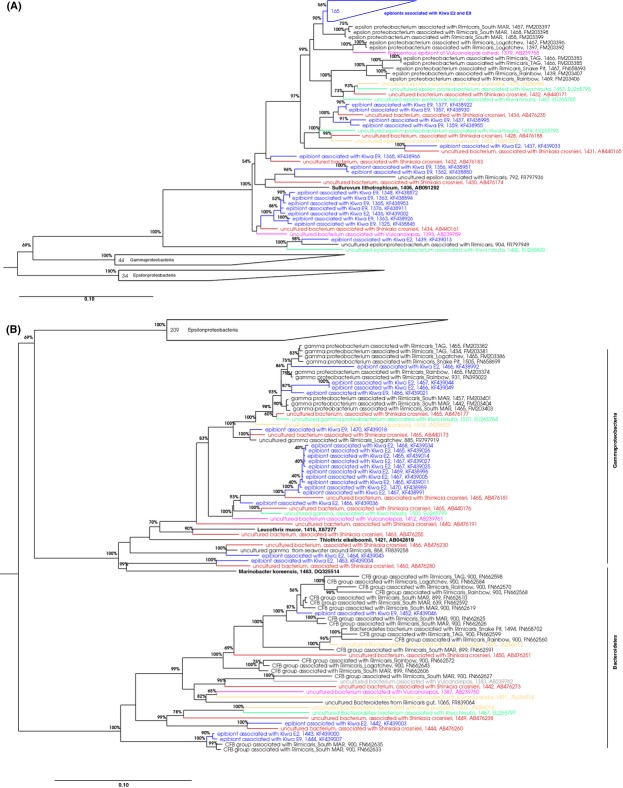
Neighbor joining tree of 16S rRNA sequences of Kiwa sp. nov. ESR (blue), Kiwa hirsuta (green), Kiwa puravida (yellow), Shinkaia crosnieri (red), Rimicaris exoculata (black), and Vulcanolepas sp. (pink). (A) Epsilonproteobacteria, (B) Gammaproteobacteria and Bacteroidetes. The tree was calculated within arb using neighbor joining with the Felsenstein correction using only sequences >1300 nt. Shorter sequences were then added by parsimony within arb. The length of each sequence is shown in the tree, followed by the Genbank accession number. Bootstrap values were calculated with the arb parsimony interactive tool. Only bootstrap values >50% are shown.